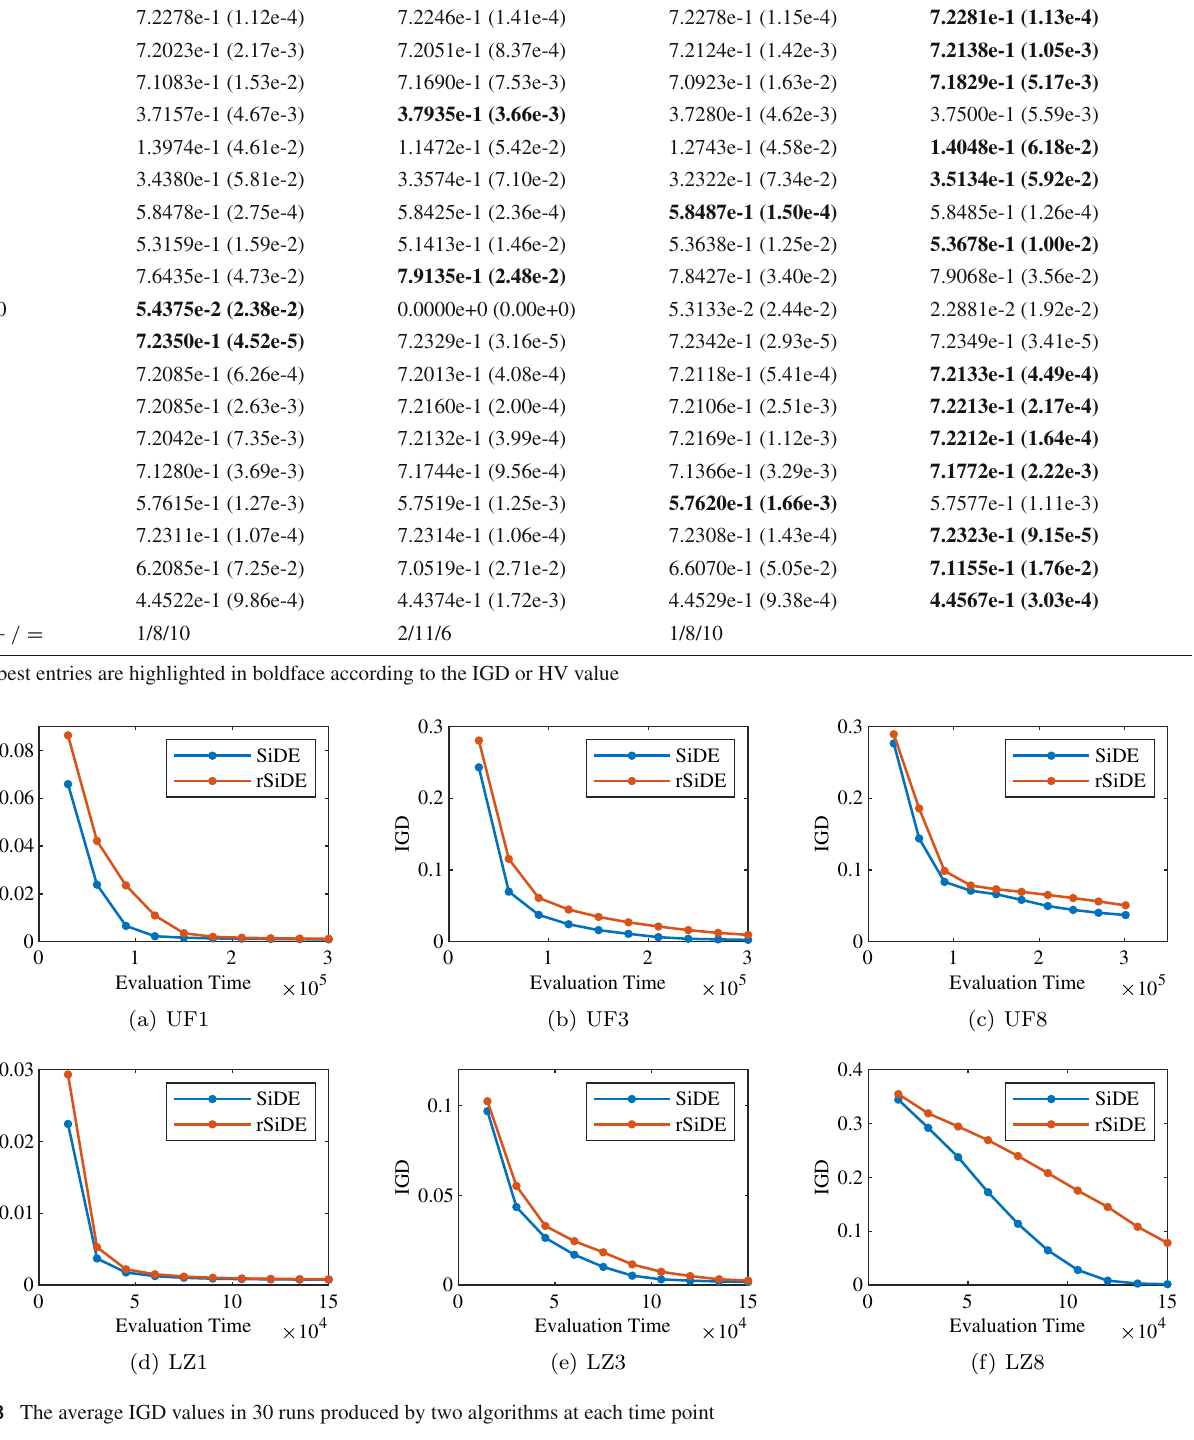
Table 7 Average and standard deviation HV values obtained by four versions of MOEA/D-CTAOS on each benchmark (30 runs) Problem